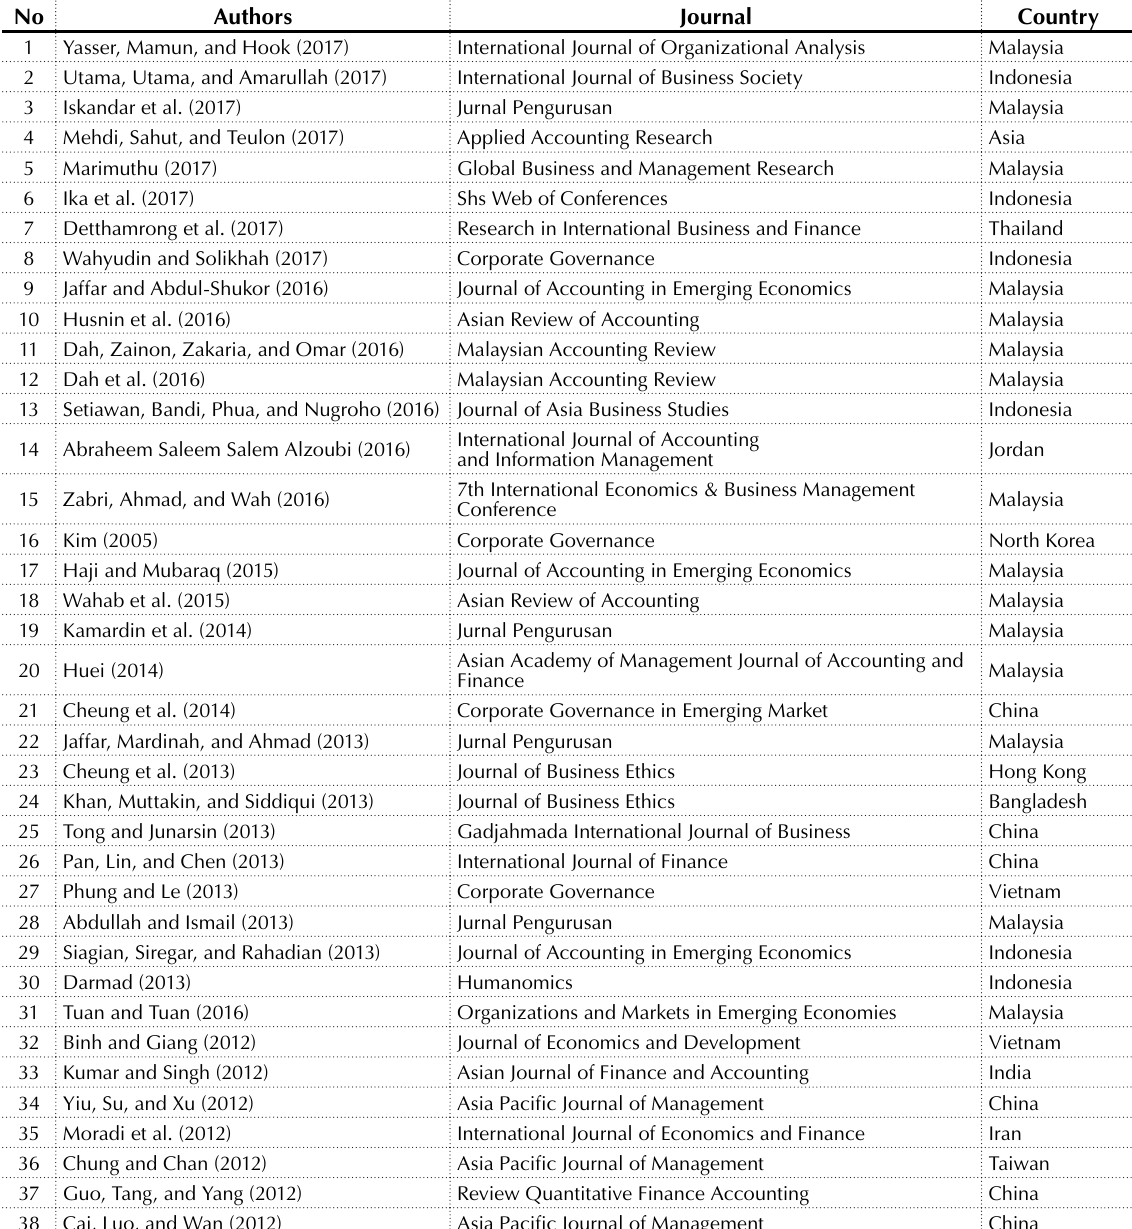
Table 1. Studies included in